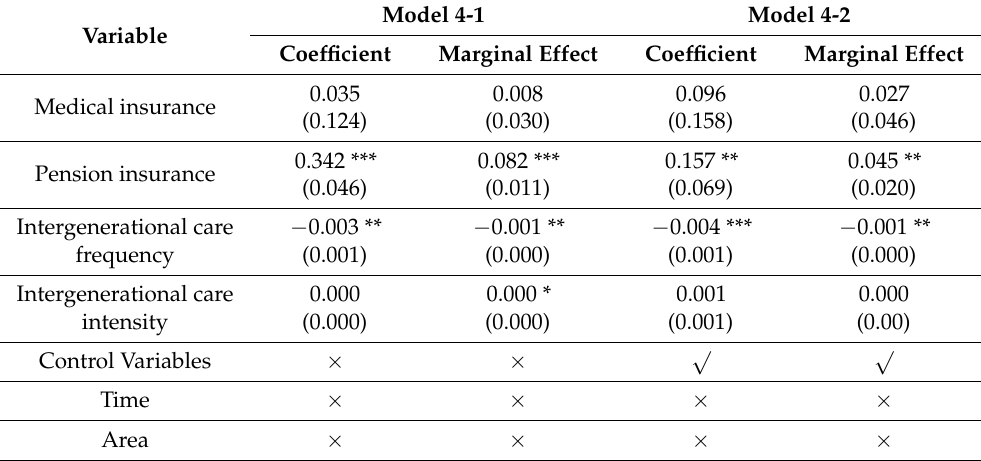
Table 4. Estimation results using the Probit